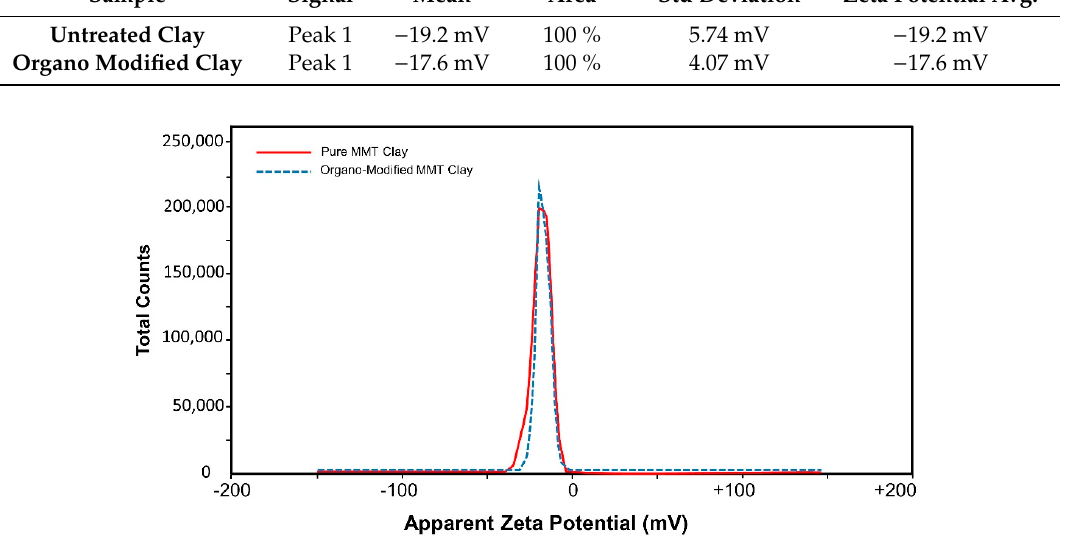
Figure 4. Zeta potential of pure montmorillonite clay and organo modified MMT clay.